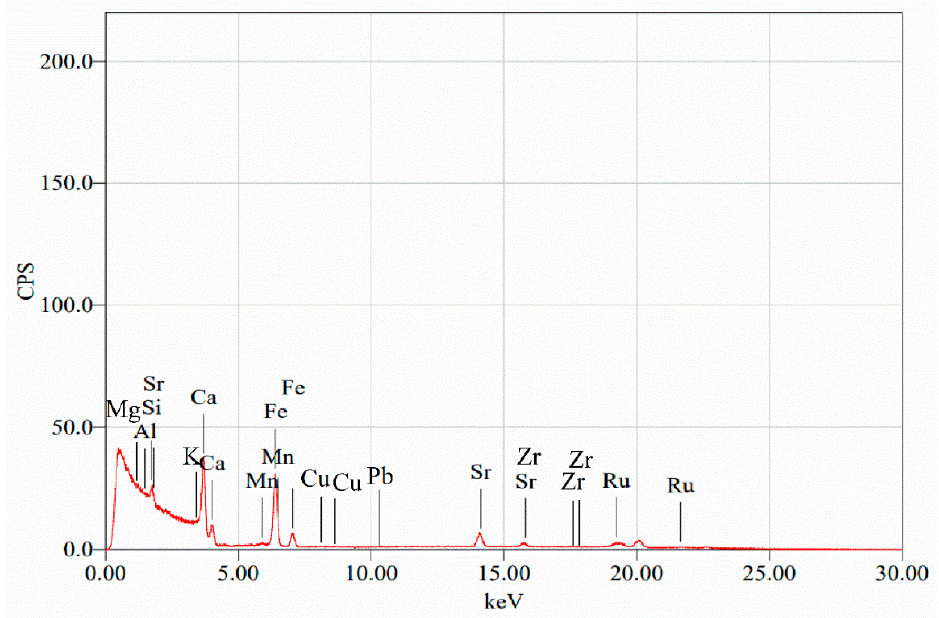
Figure 9. Elemental analysis of P. harmala seed sample-( α ) using X-ray fluorescence spectroscopy.